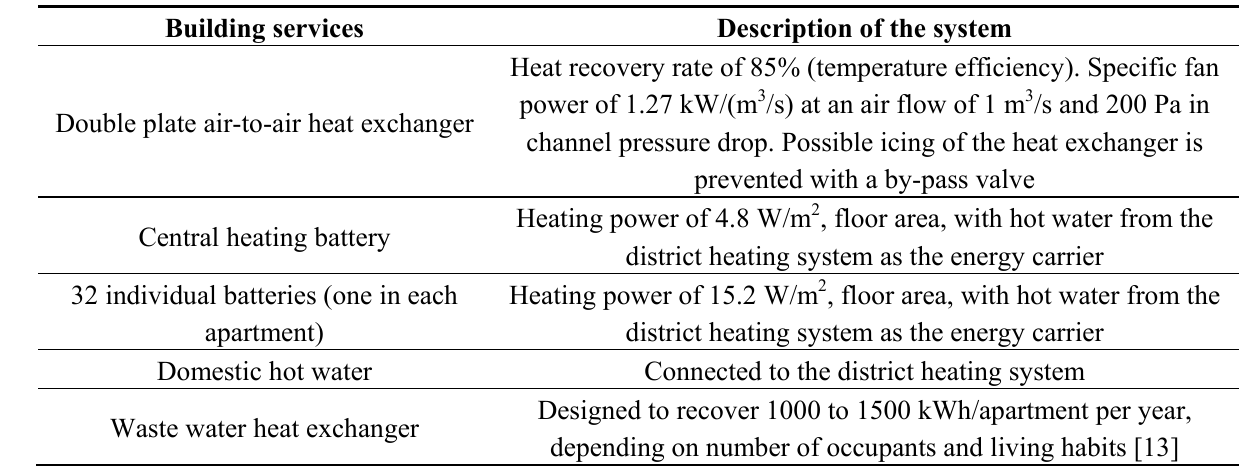
Table 3. Description of the building